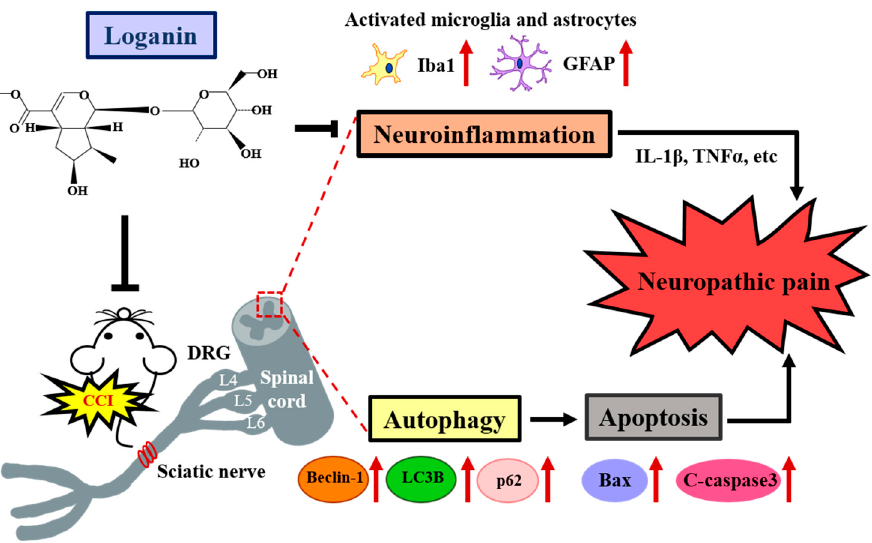
Figure 6. Proposed iridoid glycoside loganin mechanism in a CCI rat model. Loganin attenuates neuropathic pain by stimulating autophagy, inhibiting astrocyte/microglia excess activation, and reducing neuroinflammation and